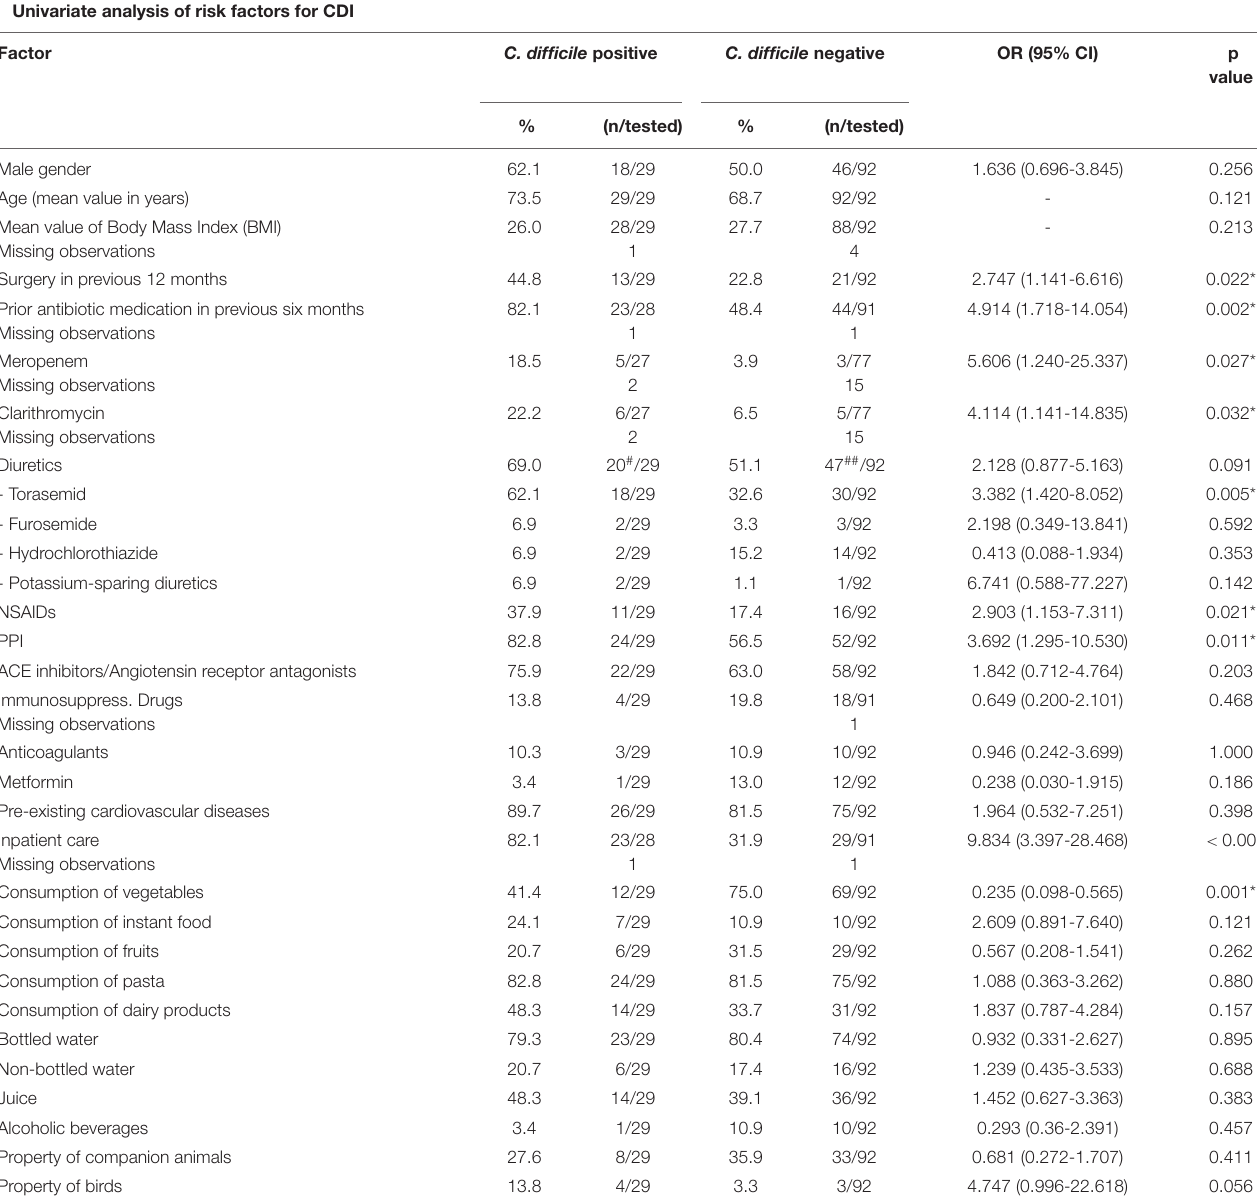
TABLE 1 | Potential risk